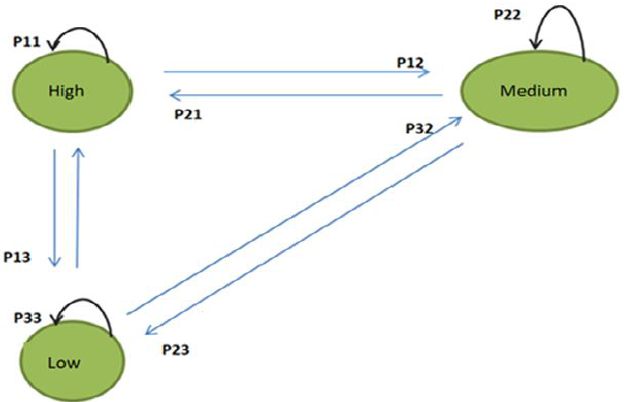
Figure 5. Possible transitions between High, Medium, and Low consumption. In order to study the role of gender in the load estimation process, the gender related characteristics of the electrified village are rated against the indicators below customized from [29,30]. For each indicator, a score of Low (1 to 2 points), Medium (3 points), and